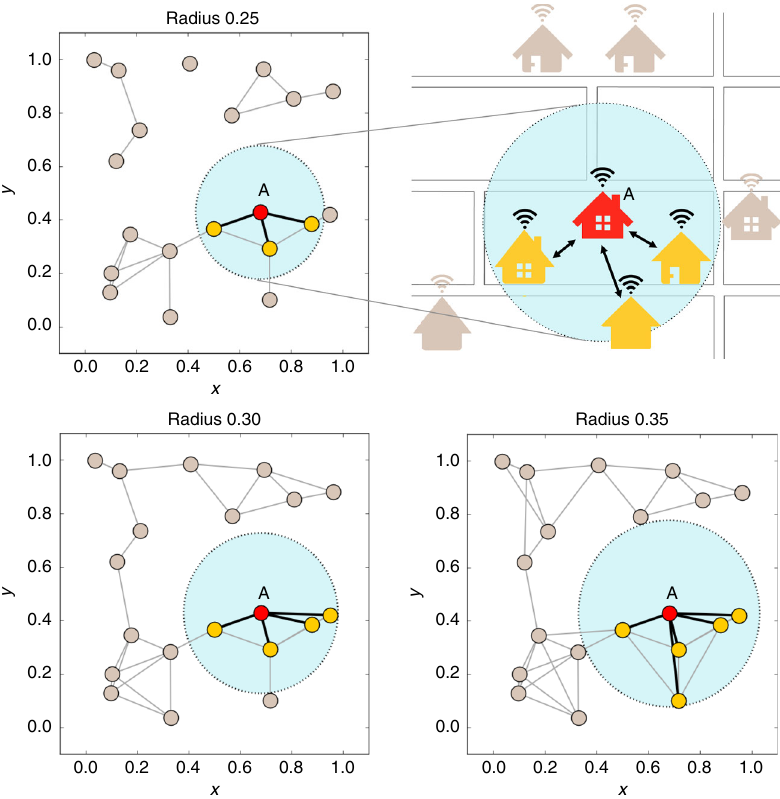
Fig. 1 Sharing game with different connection ranges. The game simulates a household Wi-Fi sharing service as an example of sharing an otherwise unusable resource. Subjects can share their resource (Internet access) with neighboring households within a particular geographic range. We generated network structures using a random geometric graph model. The model places 20 nodes uniformly at random in the unit square; two nodes are joined by an edge if the Euclidean distance between the nodes is within the speci fi ed radius. We manipulated the connection radius with three levels: 0.25, 0.30, and 0.35. By increasing the radius, as shown by the light blue circles, the network density increases; for example, the player placed at node A increases the number of neighbors with whom she or he can potentially share the resource (thus forming an actual social tie, based on the underlying technological